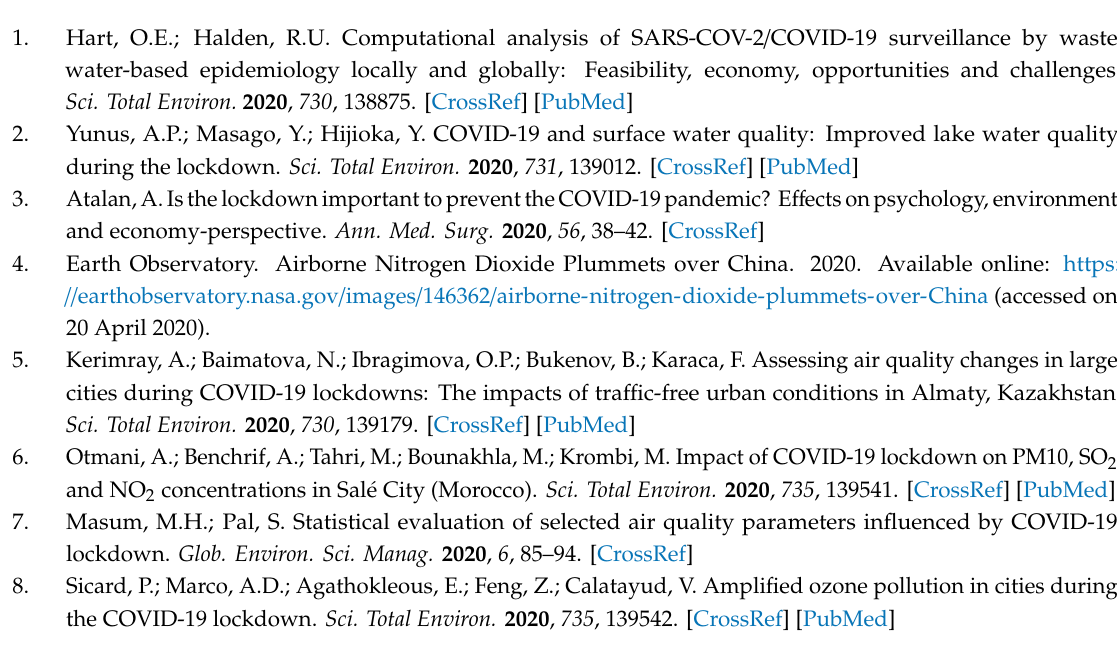
Figure A3. Variation of wind speed and vorticity at 500 hPa on 16 April 2020.